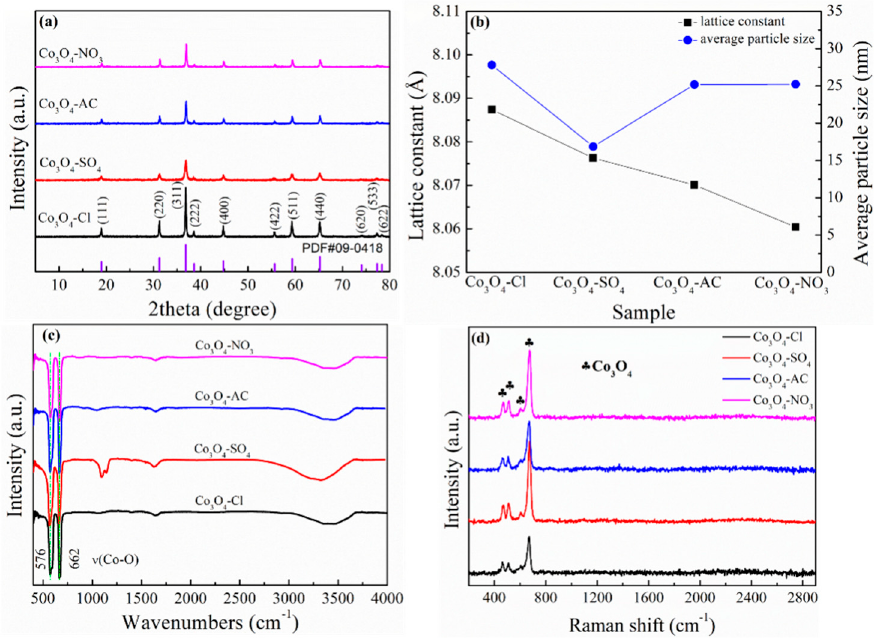
Figure 3. ( a ) XRD patterns of the calcinated products combined with the ( b ) lattice constant/average particle size, ( c ) Fourier transform infrared (FT-IR) spectra, and ( d ) Raman spectra.